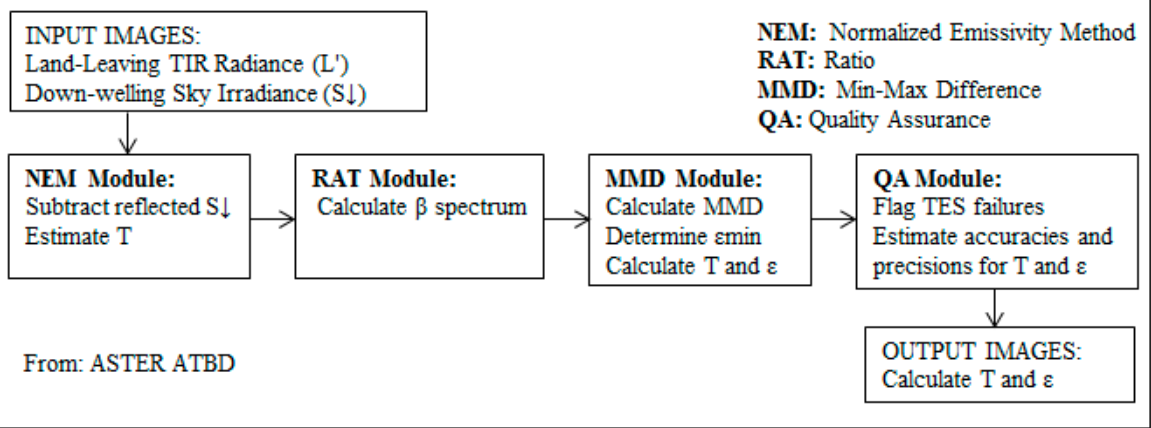
Figure 4. Basic design of the TES algorithm. The NEM module estimates